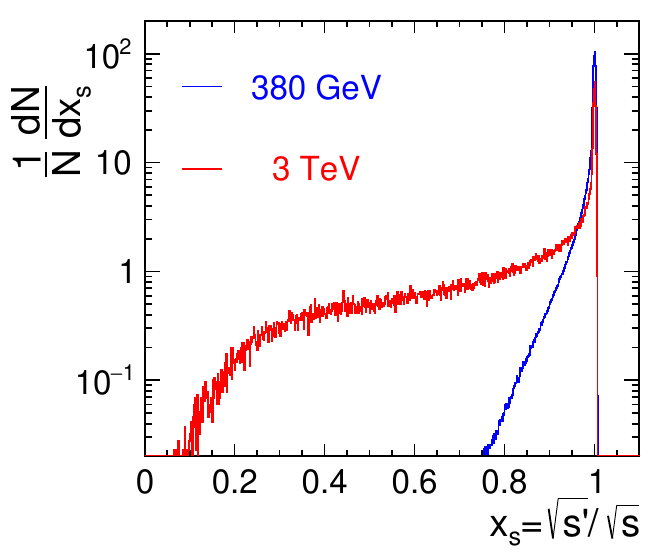
p s = 380 GeV and 3 TeV, where x p s s 0 , to the nominal